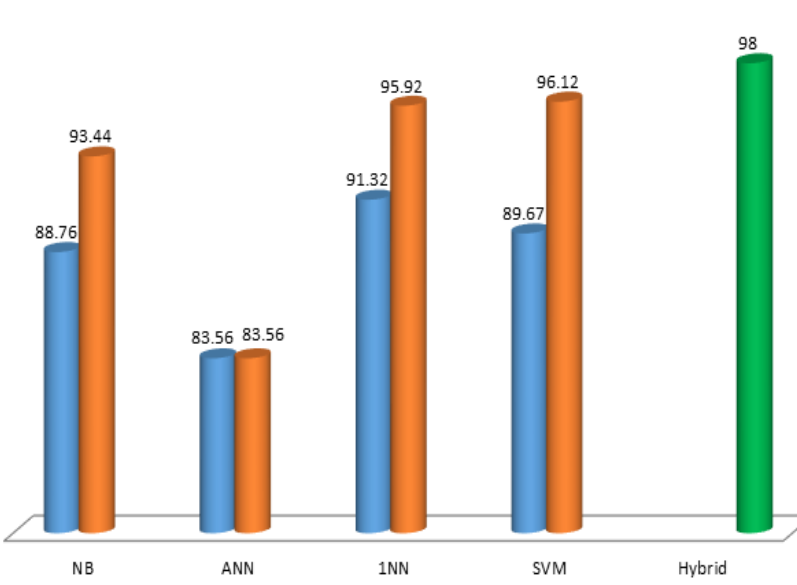
Figure 6. Prediction accuracy (in %) comparisons of three experiments.